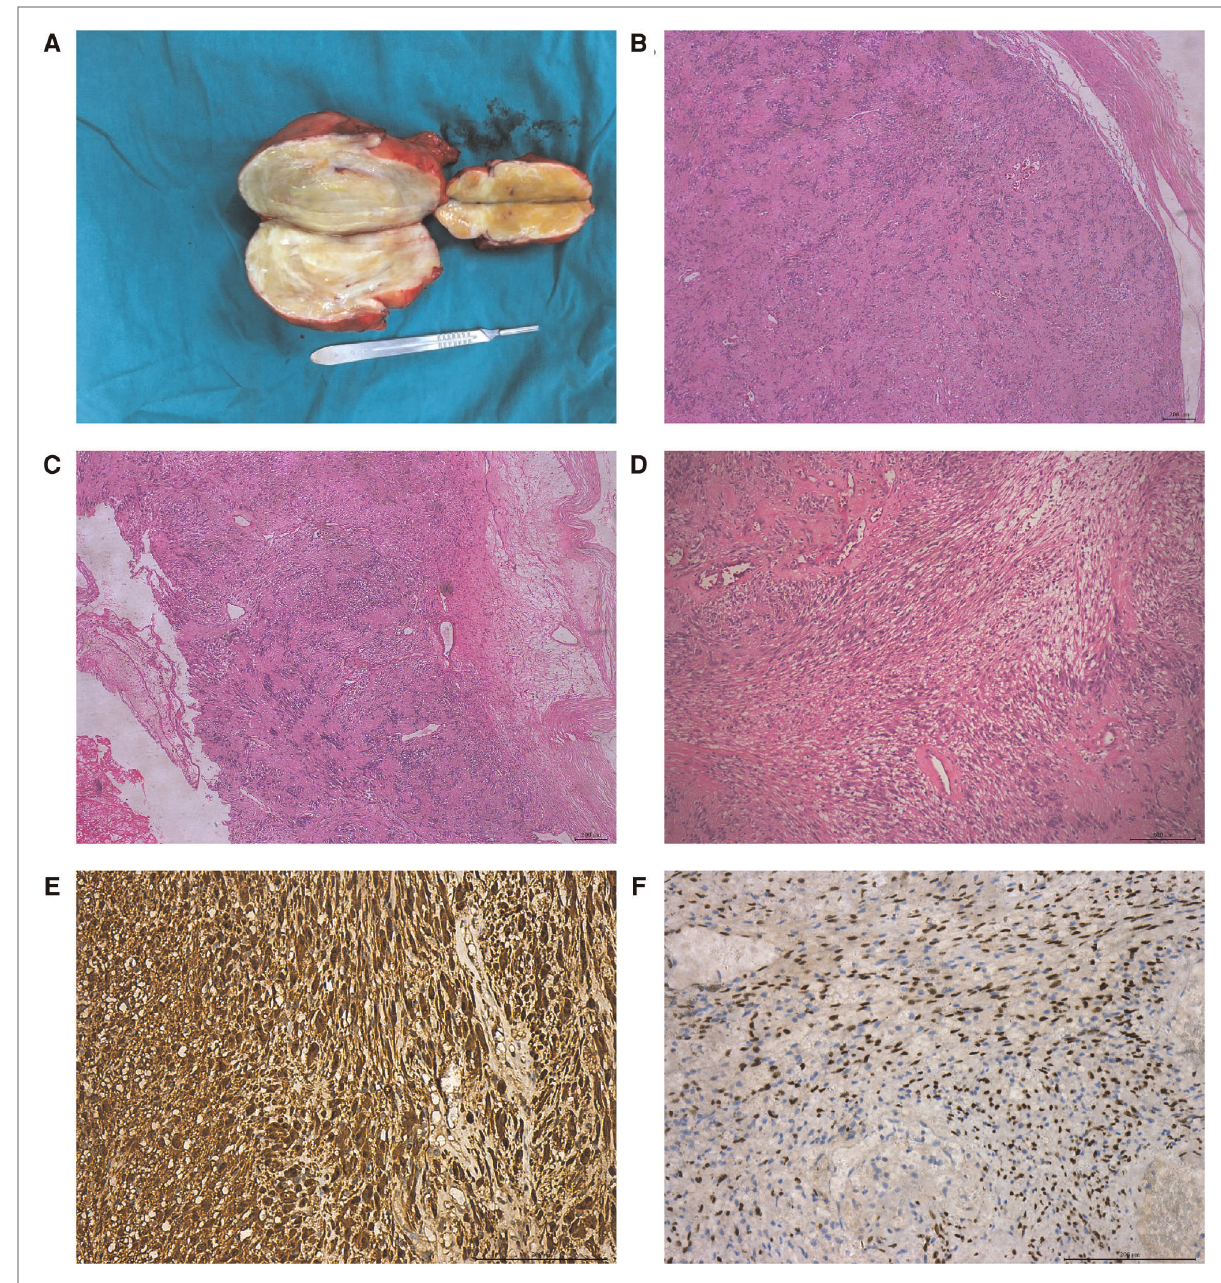
FIGURE 2 Pathological features of patients with benign AS. The gross specimen of the tumor was a gray-white round-like mass ( A ); HE staining showed that the tumor was alternately composed of the Antoni A area and the Antoni B area, showing verrucous body ( B ); mucous stroma ( C ); and transparency ( D ); immunohistochemical staining showed that S-100 protein ( E ) and SOX-10 protein ( F ) were